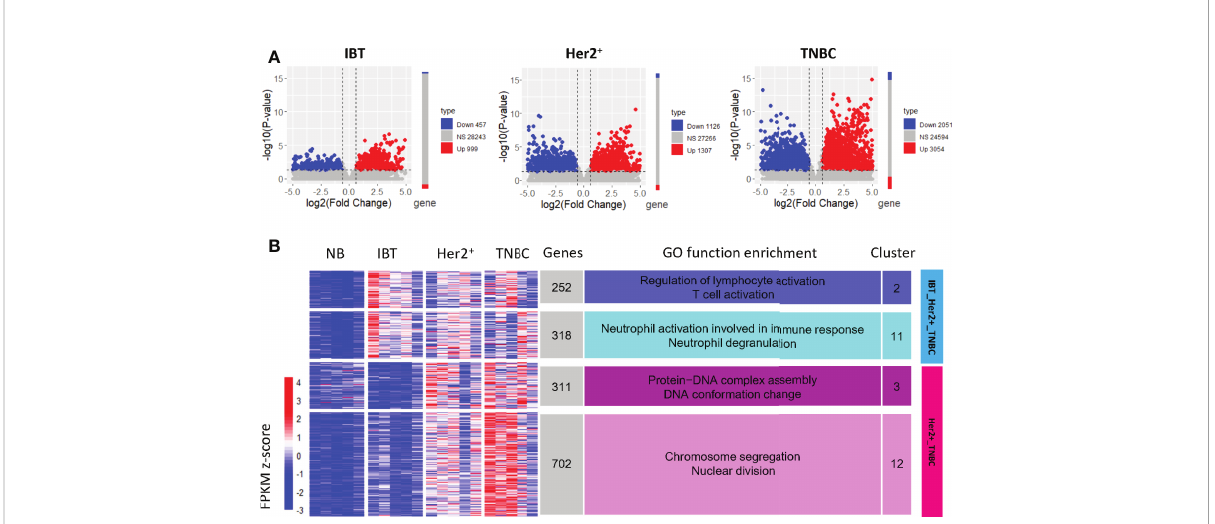
FIGURE 2 Gene clusters expressed in normal, in fl ammation, and ER − breast cancer. (A) Differentially expressed genes in each breast diseases samples compared with NB samples. Compared with normal samples, genes with upregulated expression are represented in red, genes with downregulated expression are represented in blue, and NS represents other genes. (B) The expression clusters of differentially expressed genes in IBT and ER-negative samples (Her2 + and TNBC). The main enriched functional items are listed on the right. The heatmap on the left showed the normalized expression value of the differentially expressed